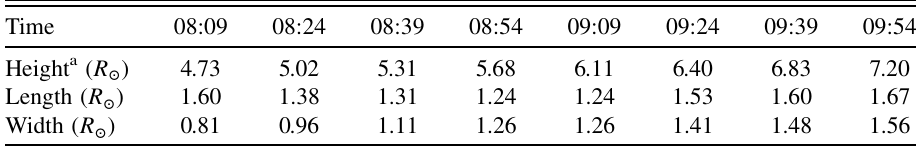
TABLE II. The morphological change of the merged blob in event 3 from 08:09 to 09:54 on 24 May